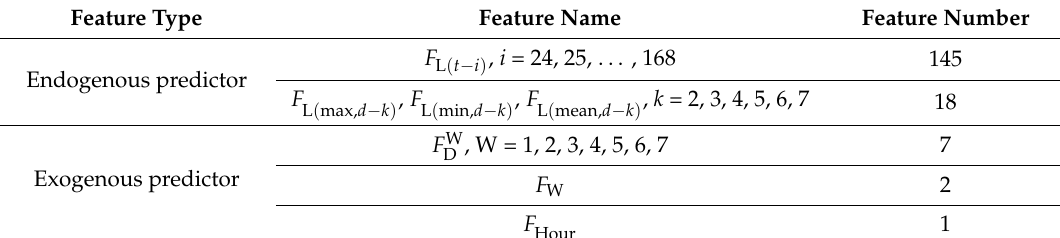
Table 1. The feature